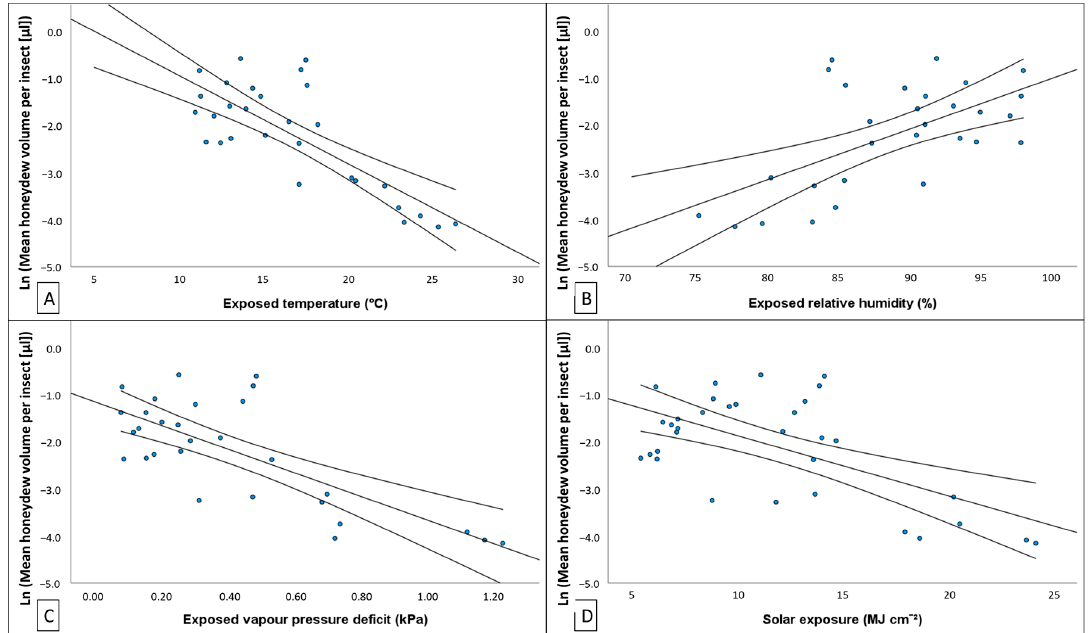
Figure 7. Relationship between natural log transformed fortnightly Marchalina hellenica honeydew excreted per insect (ln (HV [ μ L])) to ( A ) exposed temperature, ( B ) exposed relative humidity, ( C ) exposed vapor pressure deficit, and ( D ) solar exposure. Regression model is plotted as continuous black line, and curved lines indicate confidence intervals (95%) of the mean. Strong evidence was found that multiple climate variables correlate with, and explain, observed variation in ln (HV [ μ L]) (Table A12).